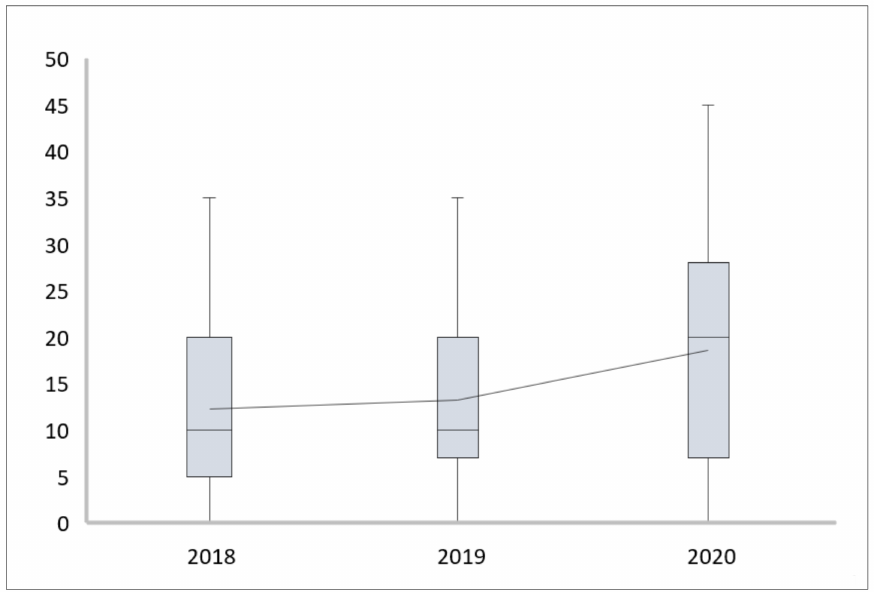
Figure 2. Comparison between 2018, 2019 and 2020 in terms of prognosis of the trauma. In 2020, the trauma occurred mostly at home (83.6% n = 58) and sport-related injuries were significantly lower (16.4% n = 11) in comparison with 2019 (28.7% n = 75) and 2018 (29.8% n = 87). In 2019 and 2018, the trauma more frequently happened away from home and was not sport-related (42.7% n = 111 and 42.9% n = 124, respectively) but due to play-related activities. Of the remaining cases for 2019 and 2018, half occurred at home (28.7% n = 75 and 29.7% n = 86, respectively) and the other half (28.6% n = 74 and 27.3% n = 79, respectively) were sport-related (Figure 3). However, no significant differences were found when comparing 2018 and 2019 in terms of the type of injury, prognosis and location of the trauma.